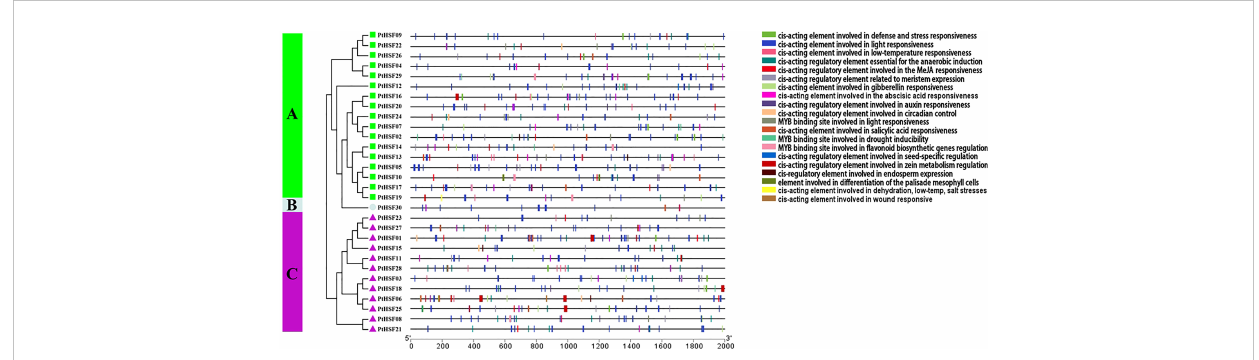
FIGURE 5 Analysis of Cis-acting elements in the HSF gene promoter in poplar. The upstream 2,000 bp sequences of 30 HSF genes were truncated and analyzed, and the blocks of different colors represented cis-acting elements with diverse